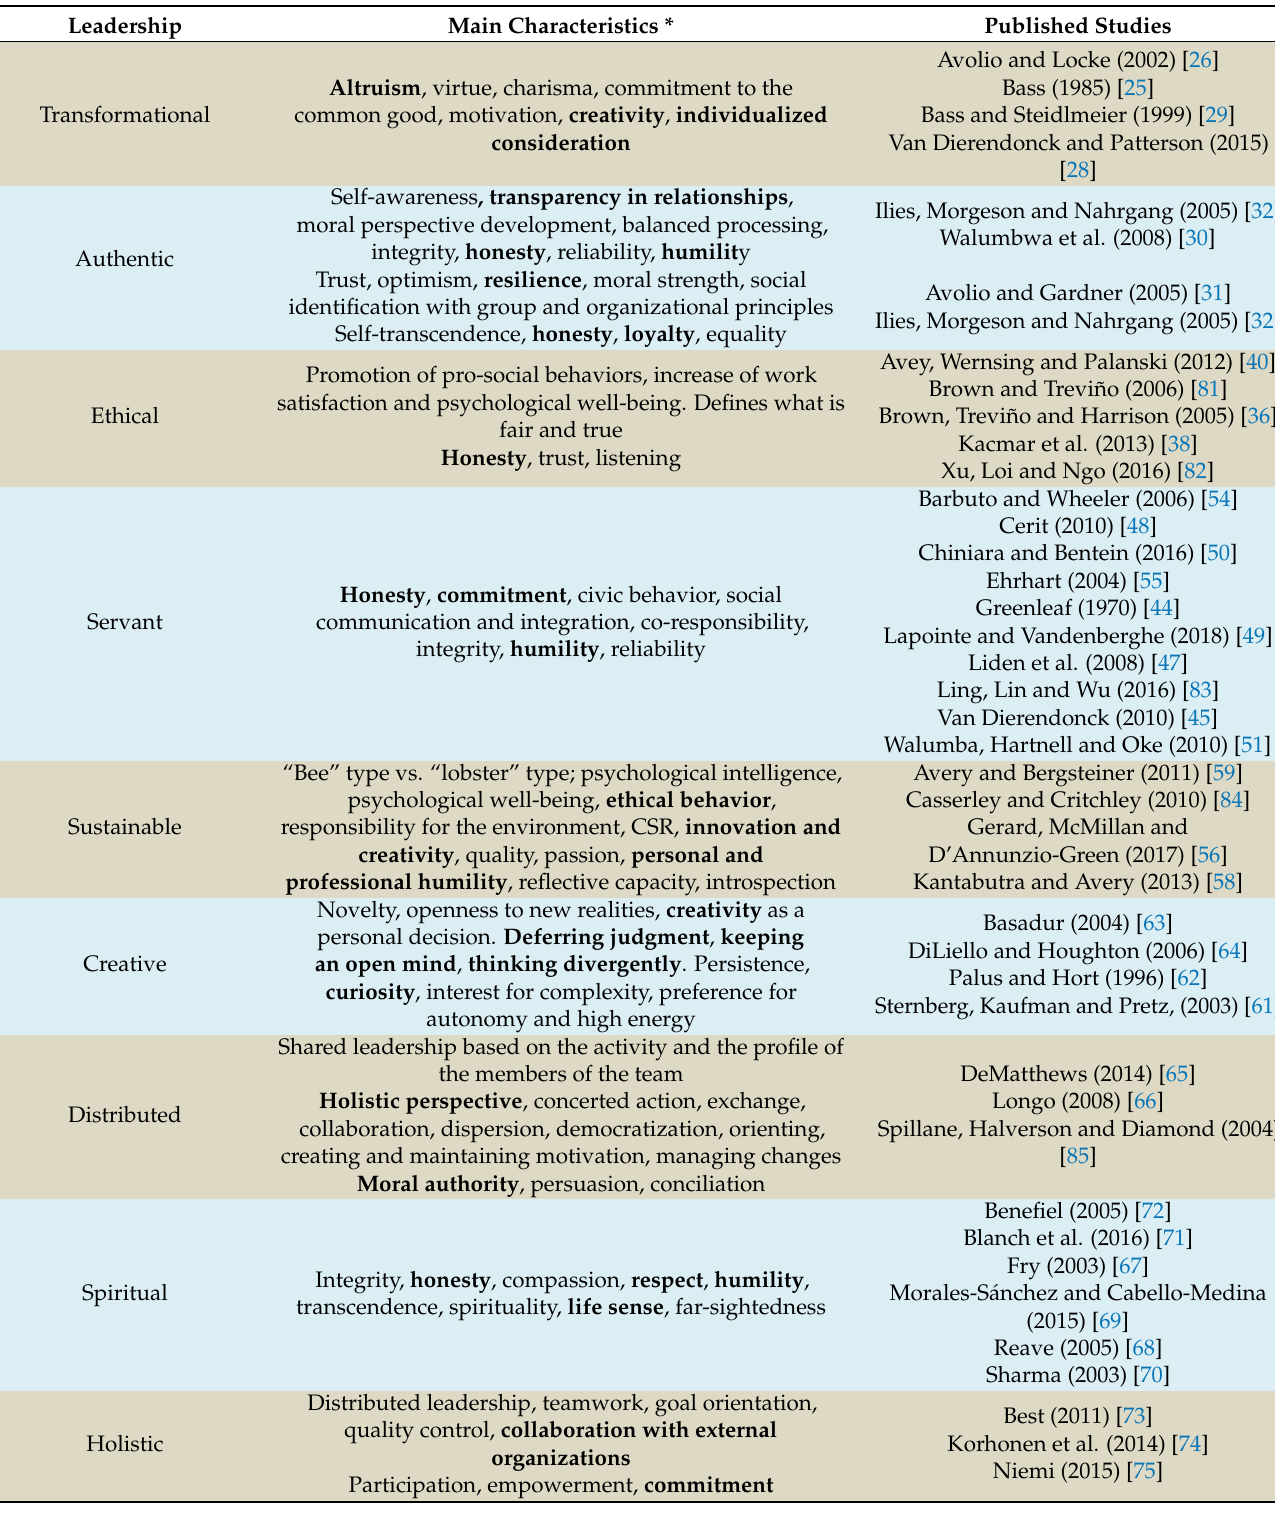
Table 1. Summary of the leadership